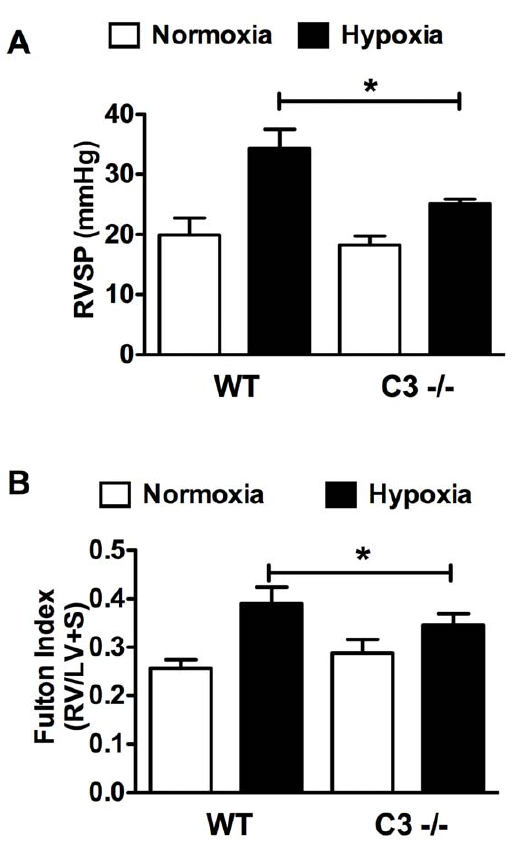
Figure 3. Genetic deletion of C3 attenuates CH-induced PAH in mice. WT or C3 2 / 2 mice were exposed to CH to induce PAH. After 3 weeks (A) RVSP and (B) RVH (Fulton index), were determined. Bars represent the mean 6 SD (n=8–12). * P , 0.05.